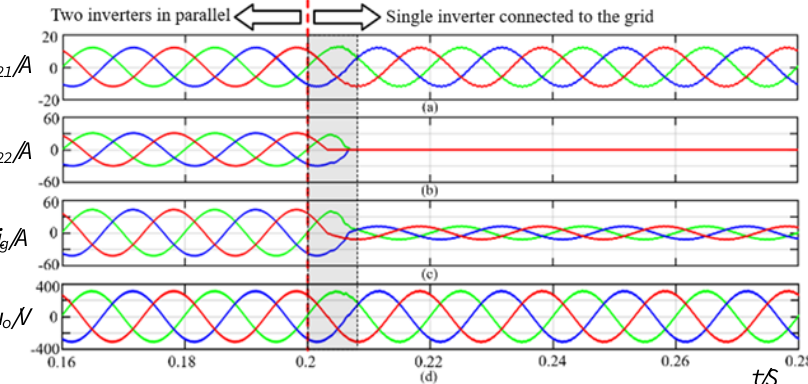
Figure 14. Simulation results of a group of parallel inverters with different capacities cutting off an inverter: ( a ) current waveform of inverter 1; ( b ) current waveform of inverter 2; ( c ) total current waveform; and ( d ) voltage waveform of PCC.